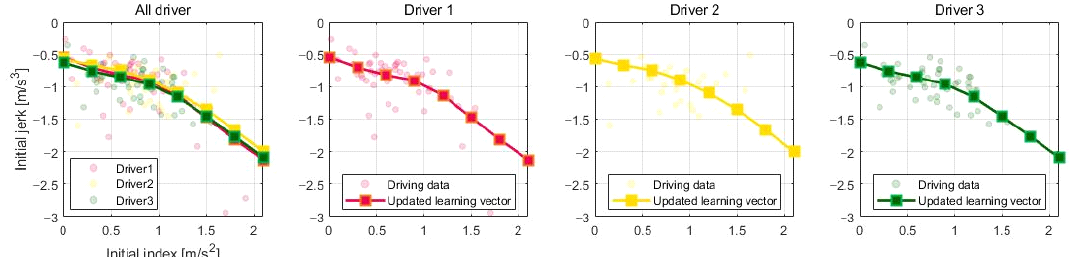
Figure 19. Learning results of learning vector for initial jerk.